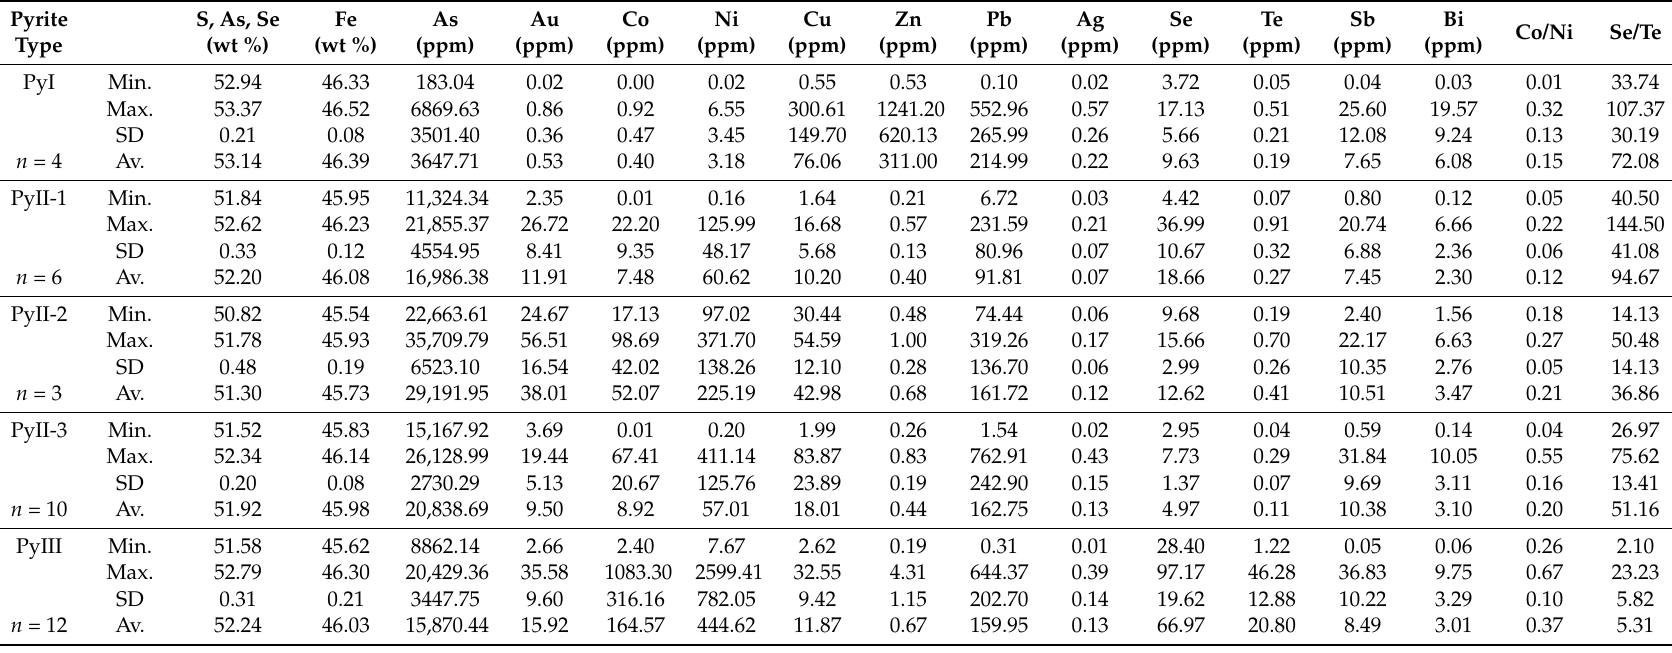
Table 3. Selected LA-ICP-MS analyses of different generations of pyrite from the Zhengchong